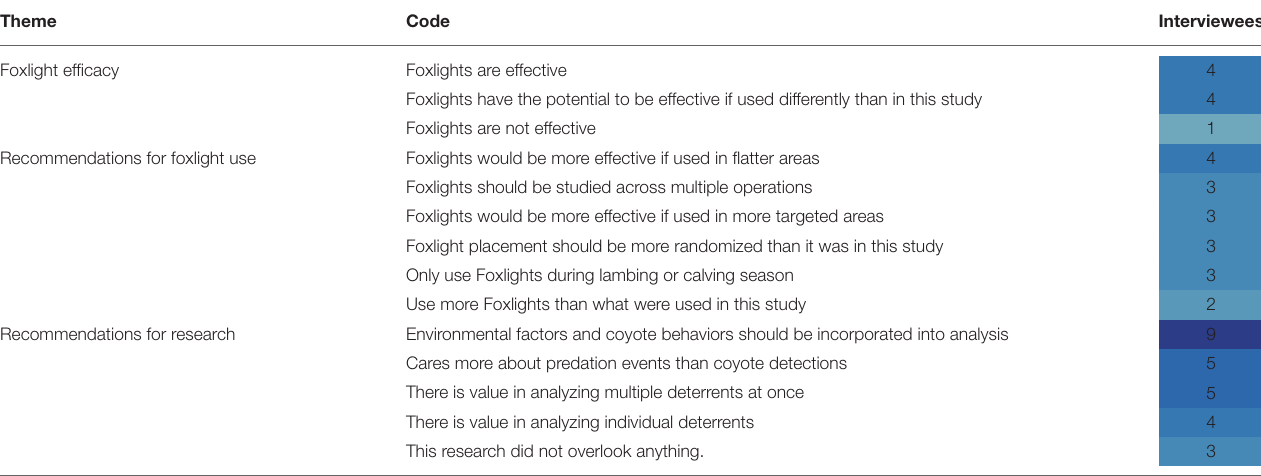
TABLE 4 | How producers interpreted the results.